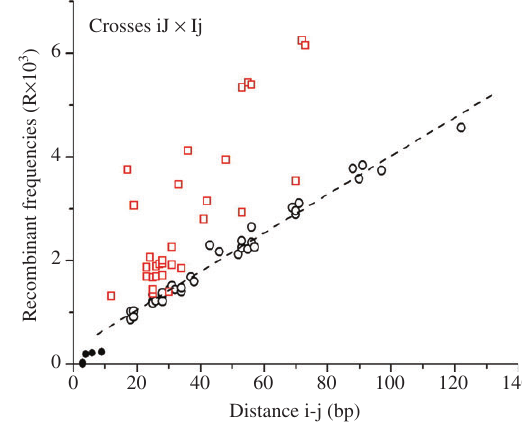
Figure 2 Distance-frequency relationship and marker effects in two-factor iJ × Ij crosses (46) . The markers i and j are mutations in the proximal part of rIIB gene. R designates the frequency of rII + recombinants. Open circles mark crosses between single-nucleotide mutants of base substitution or indel type; squares mark crosses in which either one or both mark- ers were mutations with more than one changed nucleotides of base substitution or indel type (Figure 1). The regression line was drawn through the points marked by open circles (basic recombination) by the least squares method. Filled circles correspond to the crosses at ultrashort distances. They deviate signifi cantly from the regression line because of marker interference (61)